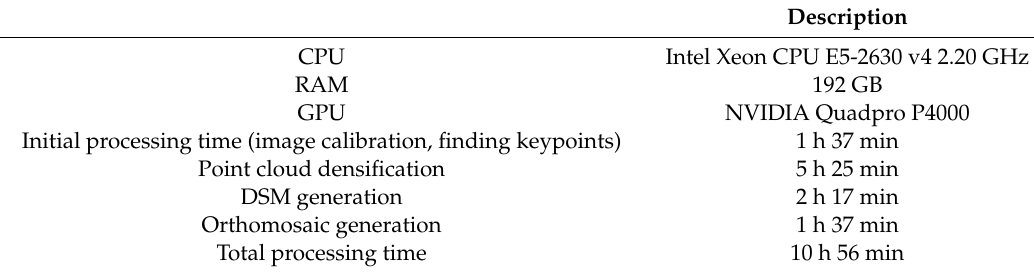
Table A3. Hardware and processing time for image processing conducted in